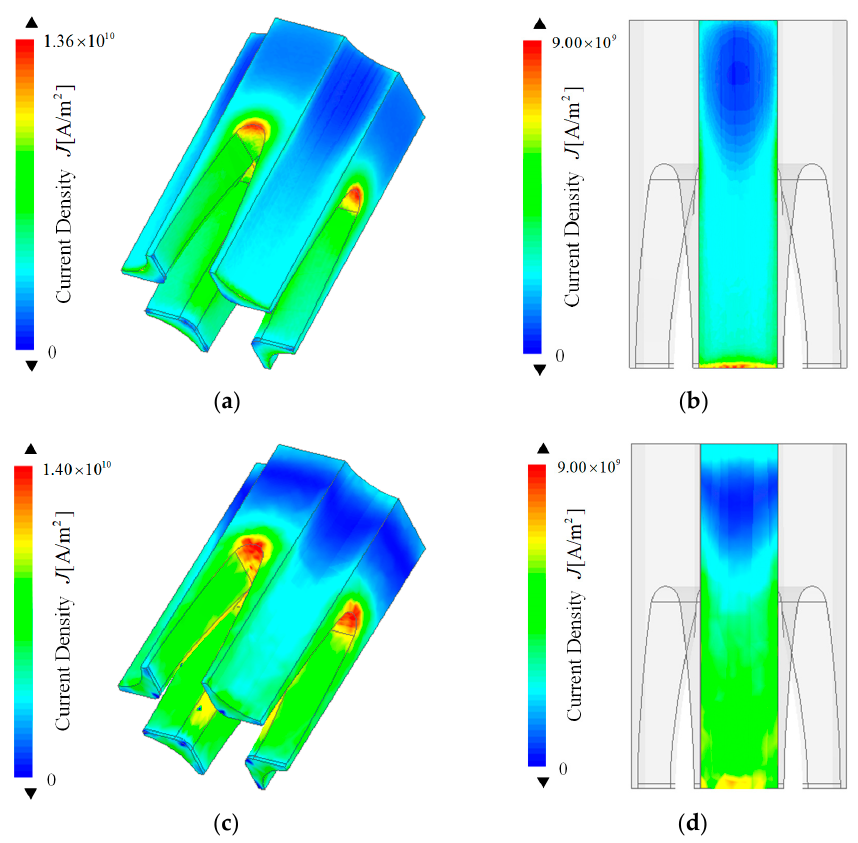
Figure 3. Armature and contact surface current density distribution: ( a ) nonenhanced armature; ( b ) nonenhanced armature and rail contact surface; ( c ) enhanced armature; and ( d ) enhanced armature and rail contact surface.